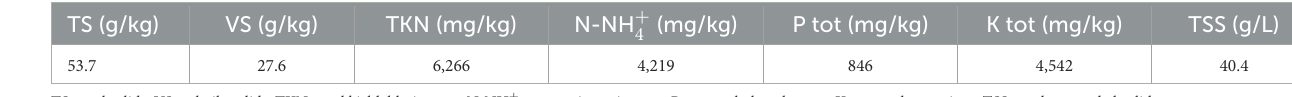
TABLE 1 Physicochemical composition of the liquid microfilterd digestate used as